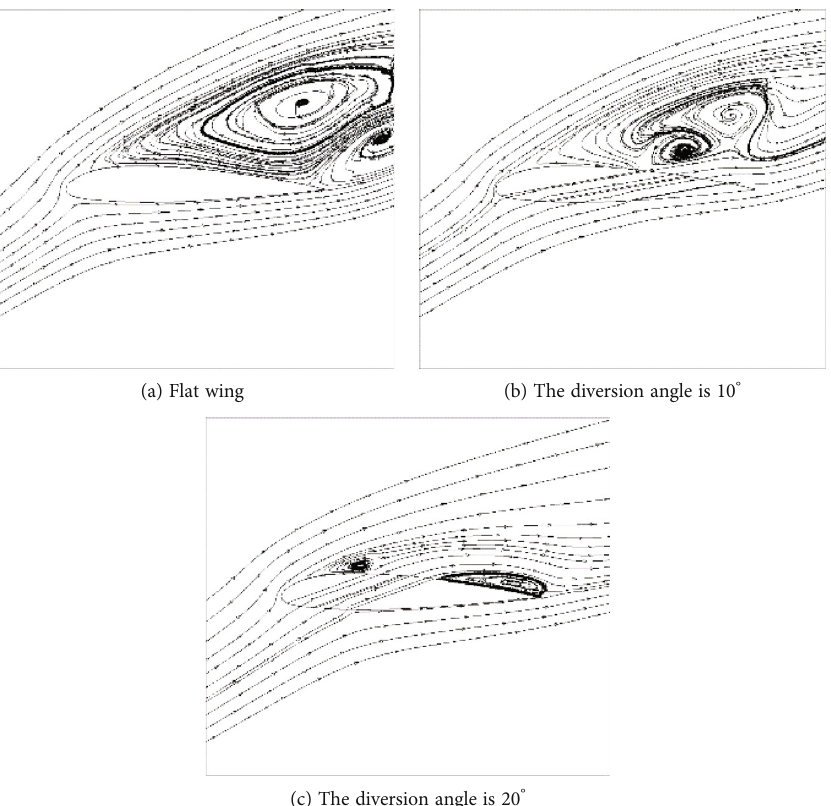
Figure 20: Fluid streamline diagrams of grid fusion lifting surface with di ff erent diversion angle ( Ma = 0 : 6 α = 28 ° z / b = 0 : 75 ).